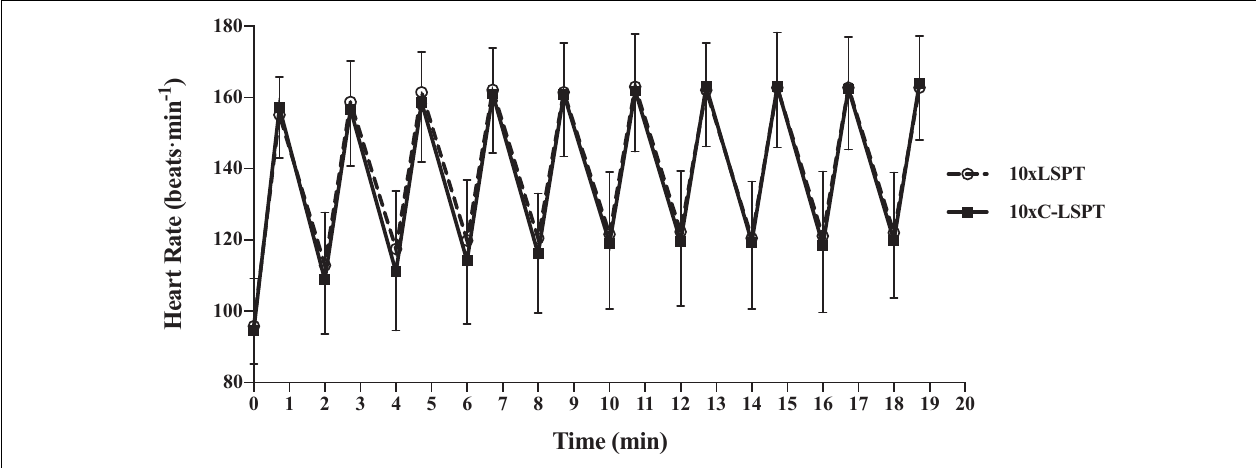
FIGURE 4 | Heart rate in two motor tasks. 10xLSPT, 10 repeats of Loughborough Soccer Passing Test; 10xC-LSPT, 10 repeats of modified Loughborough Soccer Passing Test in clockwise order of pass direction. When analyzing the response accuracy of Stroop-3, no significant main effect of time [ F (1, 13) = 0.030; p = 0.866, η